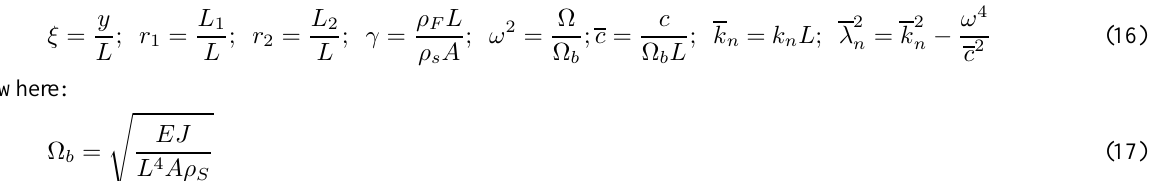
Fig. 3. The second structural frequency parameter of the coupled system as a function of the position of the crack. The fluid is considered to be incompressible without